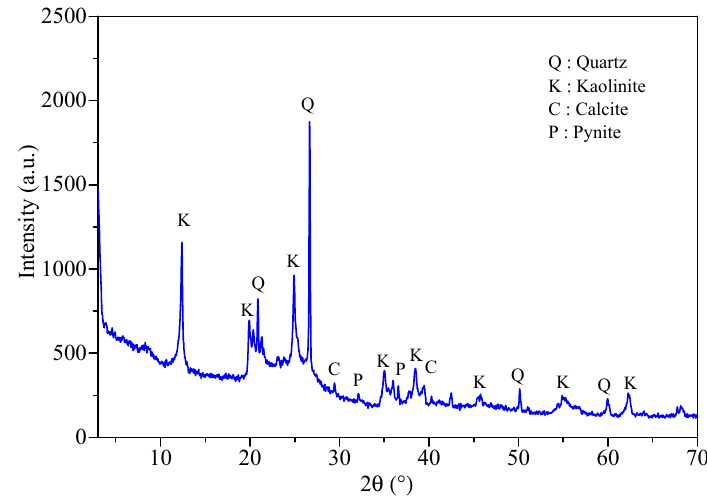
Figure 2. XRD pattern of the tectonic coal.